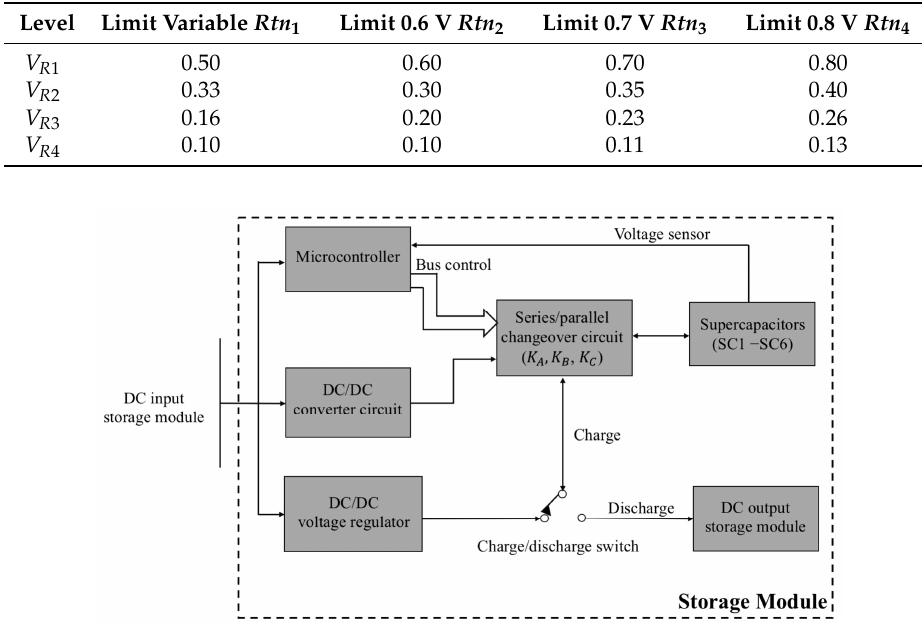
Figure 6. Schematic diagram of the operation of the storage bank.